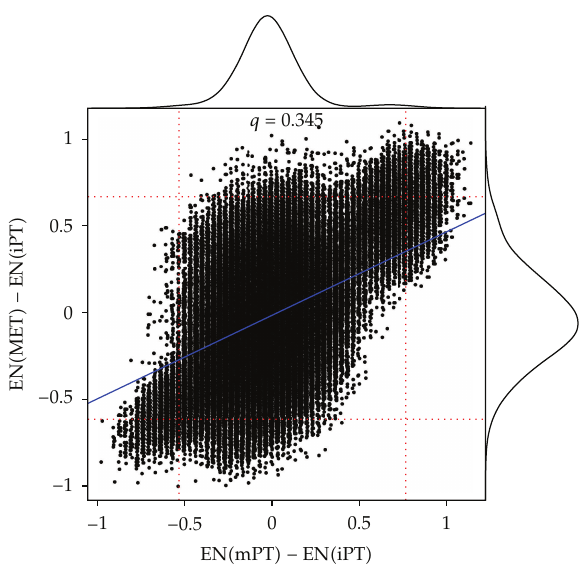
Figure 7: Scatterplot of the enrichment scores of the METS versus those of mPTs, normalized by the enrichment scores of iPTs. Kernel density estimation curves are shown protruding from the x and y axes. The horizontal and vertical dashed red lines denote the trim points (cid:2) quantiles 0.99 and 0.01 (cid:3) . A linear regression line, based on the trimmed values, is shown in blue. The value of q is the Pearson correlation coe ffi cient for the trimmed x and y